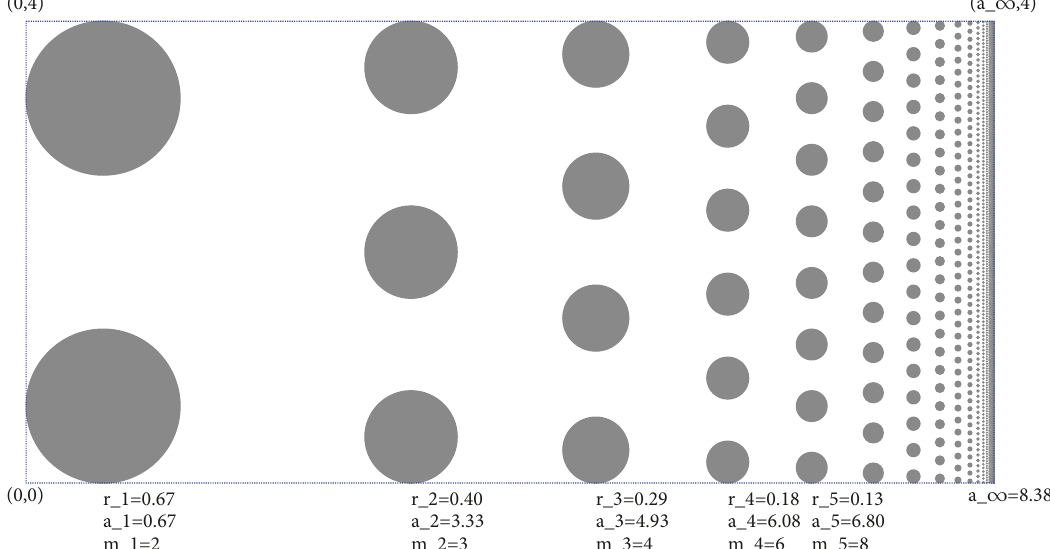
Figure 5: Compact set 𝐶 (in gray) from Example 2 with 𝑚 ℎ = ⌈(3/2) ℎ ⌉ . (The blue, dotted rectangle has corners (0,0) and (𝑎 ∞ ,4) and is not part of 𝐶